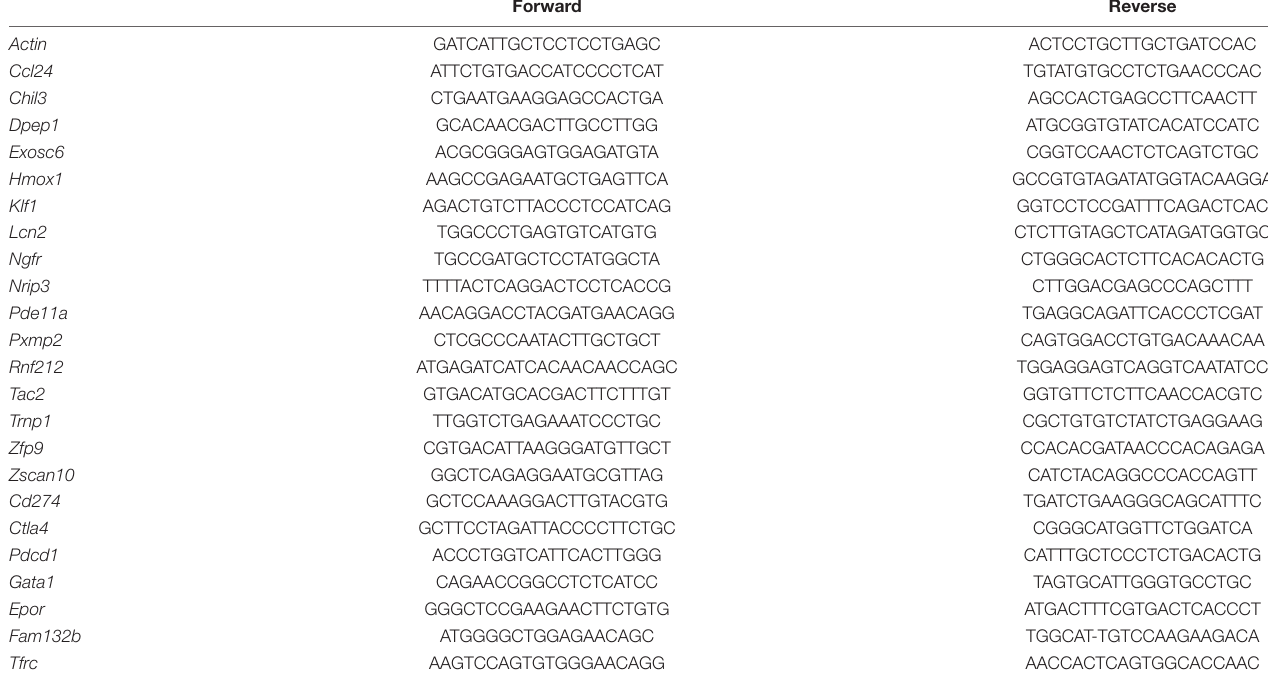
TABLE 1 | Primers used in the